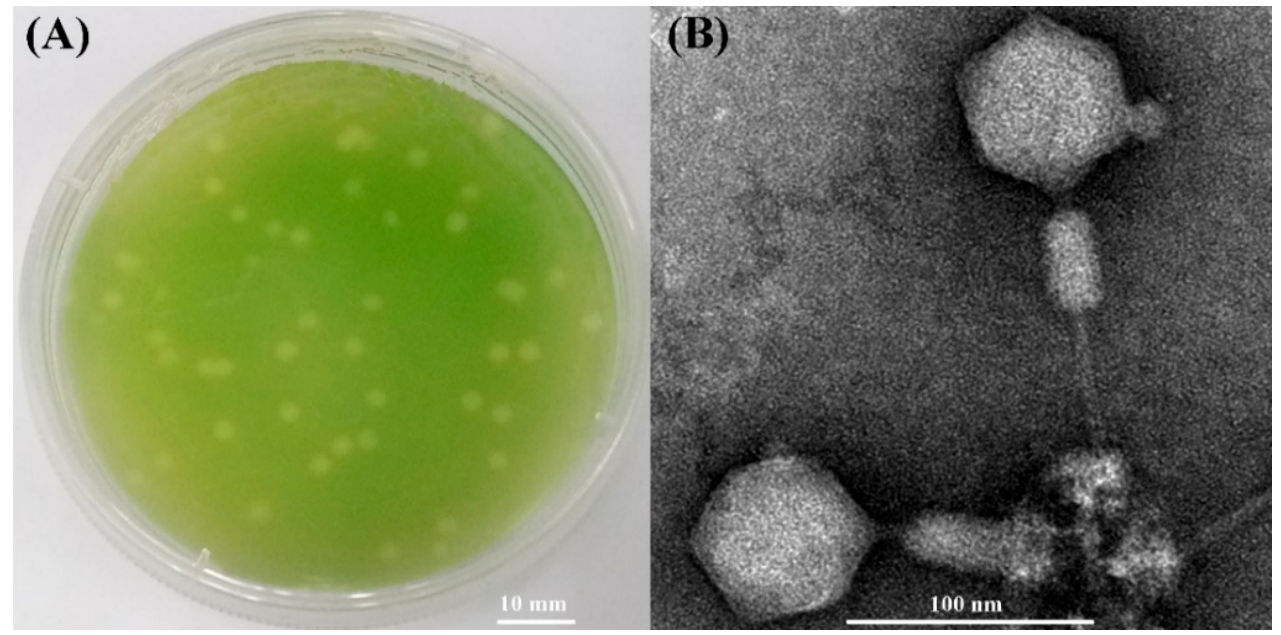
Figure 1. ( A ) Plaques of cyanophage S-SZBM1 formed on the lawn of Synechococcus CB0101. ( B ) Transmission electron micrograph of cyanophage S-SZBM1 with non-contracted tail and contracted tail.